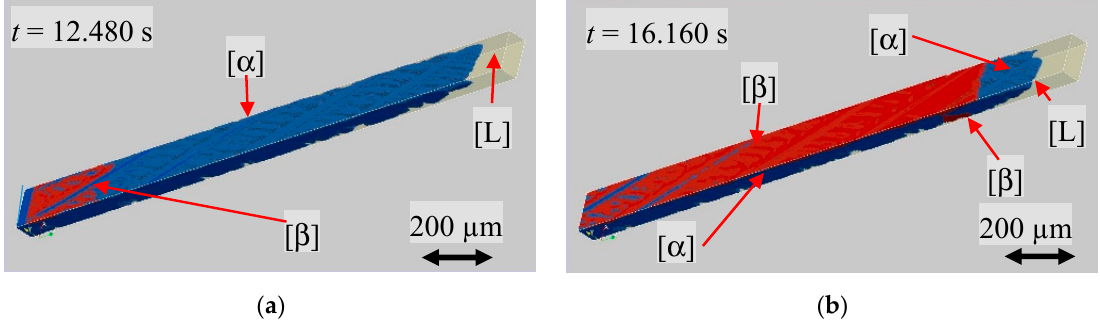
Figure 10. ( a ) Nucleation event of the peritectic β -phase (red) at the numerically set temperature of 397 K and ( b ) growth of the β -phase along both glass walls.